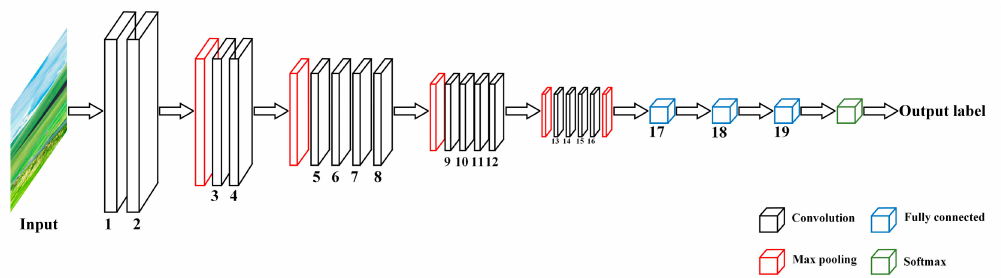
Figure 3. VGG-19 structure. Numbers 1-16 are the convolutional layers, numbers 17–19 are the fully connected